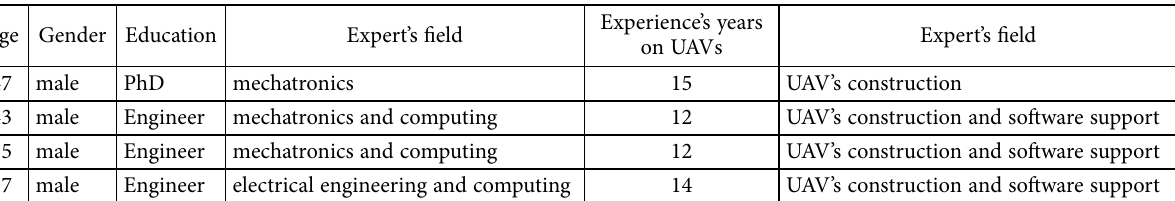
Table 3. Experts’ characteristics